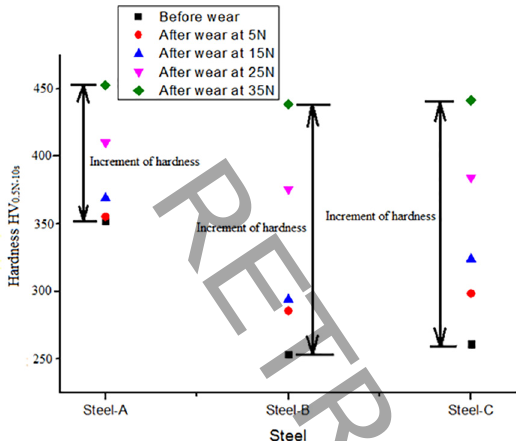
Figure 6. Results of micro-hardness test before and after wear tests for Steel-A, Steel-B and Steel-C. the results of hardness tests for Steel-B and Steel-C, the Steel-B has slight variations in hardness of Steel-C. This shows that Steel-B is having very similar hardness property ductile behaviour of Steel-B as obtained after oil quenching.